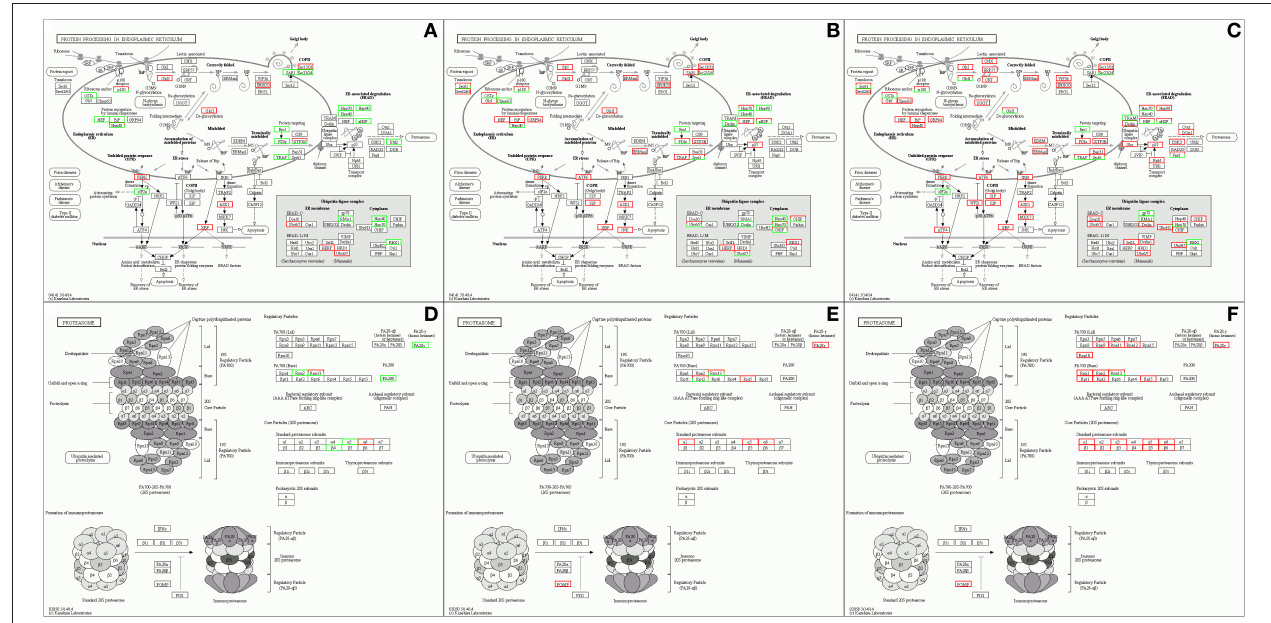
FIGURE 7 | Pathway enrichment analysis of the differentially expressed mRNAs The enrichment results related to protein processing in the ER in Qiufeng vs. Baiyu (A) , Qiufeng vs. Nd-s D (B) and Qiufeng vs. Nd (C) and the enrichment results related to the proteasome in Qiufeng vs. Baiyu (D) , Qiufeng vs. Nd-s D (E) and Qiufeng vs. Nd (F) are